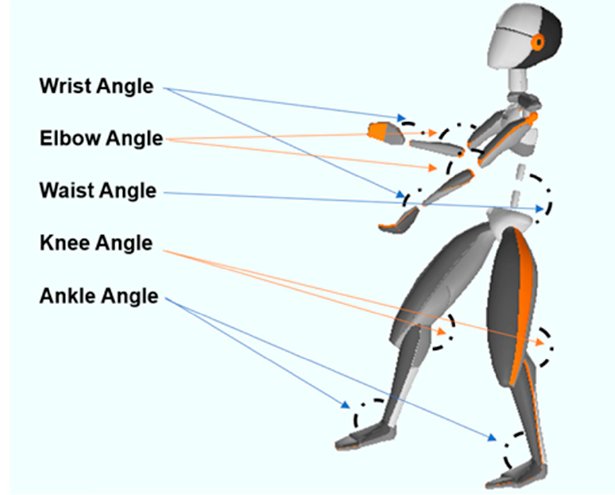
Figure 1. The joints used to represent subjects’ posture.